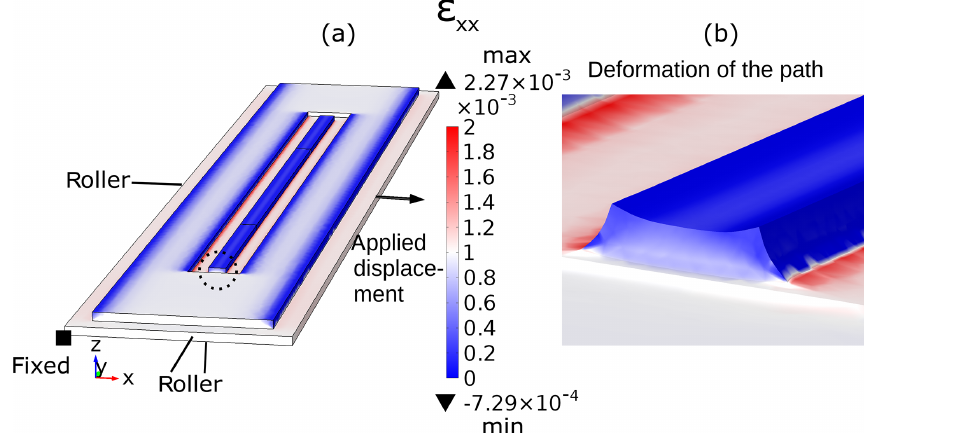
Figure 2. The FEA model (according to Fig. 1) is composed of an aluminum plate and a polyimide SG with a stand-alone path ( h = 30µm and w = 100µm). The boundary conditions (roller, fixed and displacement) are marked accordingly. (a) The resulting strain (cid:15) xx of the model. (b) The deformation of the circled path section that occurred (with a scale factor of